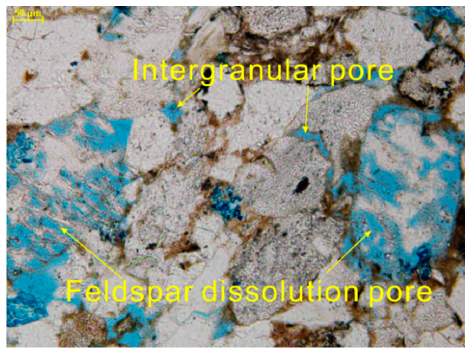
Figure 10. Feldspar dissolution pore and intergranular pore of the MSMFT type of pore-throat structure (Sample #16).